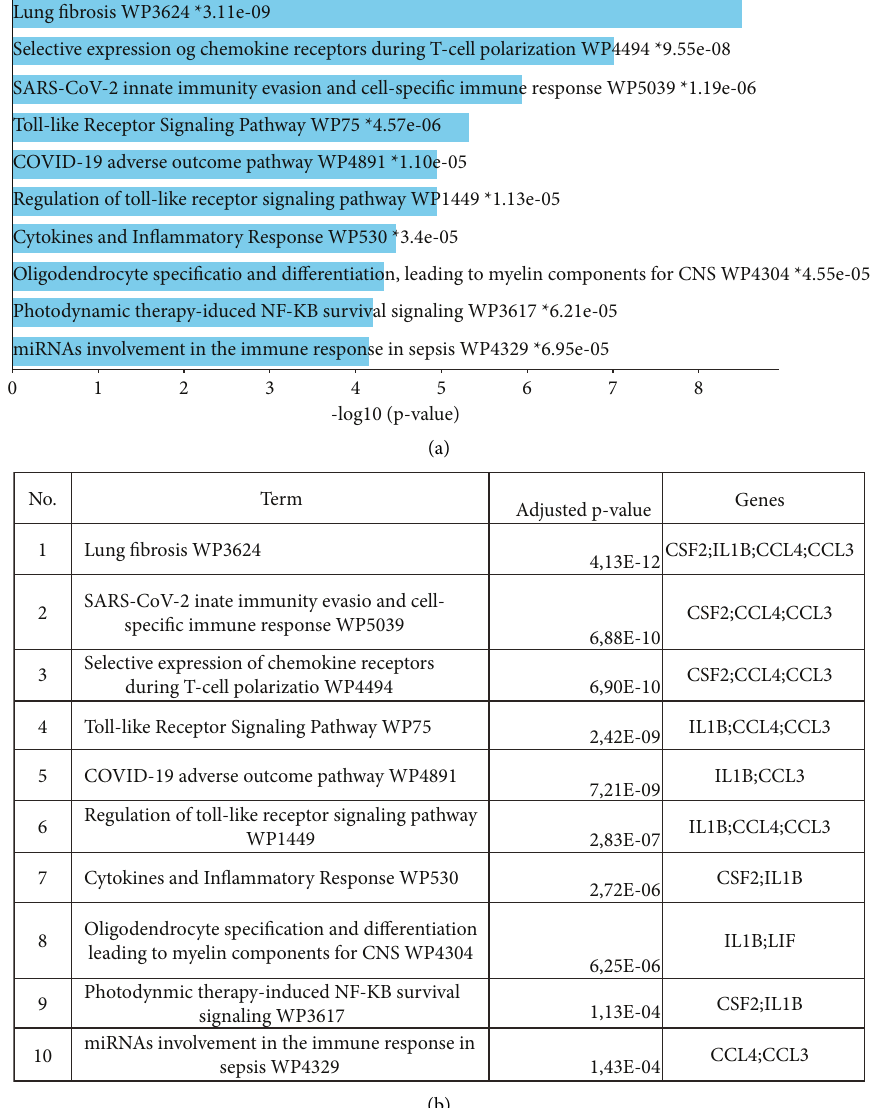
Figure 3: Annotations of genes contributed to COVID-19 severity. List of contributed pathways (a) and additional information about contributed pathways and list of genes